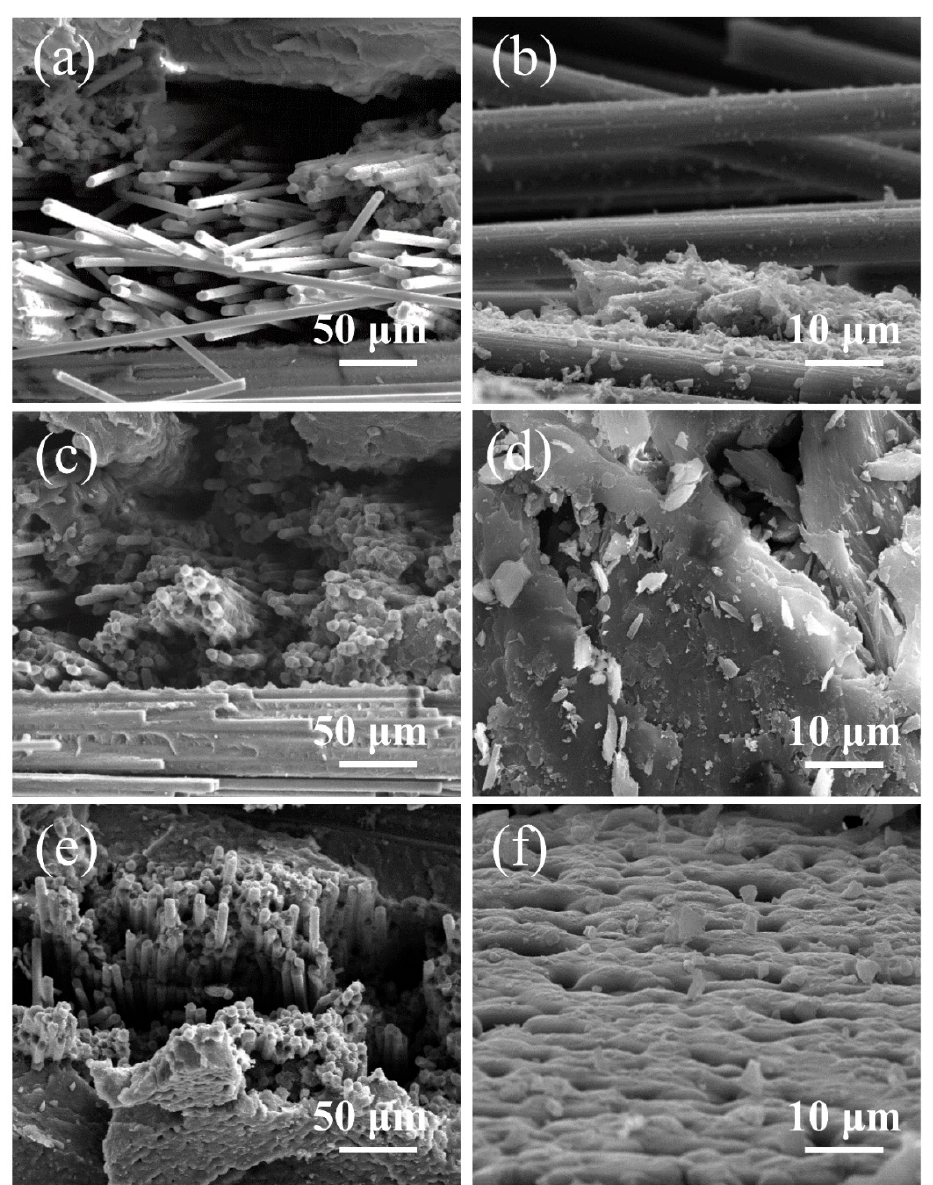
Figure 9. The morphology of CF/PEEK composites with different PEEK mass ratio after the tensile test: ( a ) Fracture morphology of composites with 6-strand PEEK fibers; ( b ) The morphology of CFs in composites with 6-strand PEEK fibers; ( c ) Fracture morphology of composites with 12-strand PEEK fibers; ( d ) The morphology of PEEK resin in composites with 12-strand PEEK fibers; ( e ) Fracture morphology of composites with 18-strand PEEK fibers; ( f ) The morphology of PEEK resin in composites with 18-strand PEEK